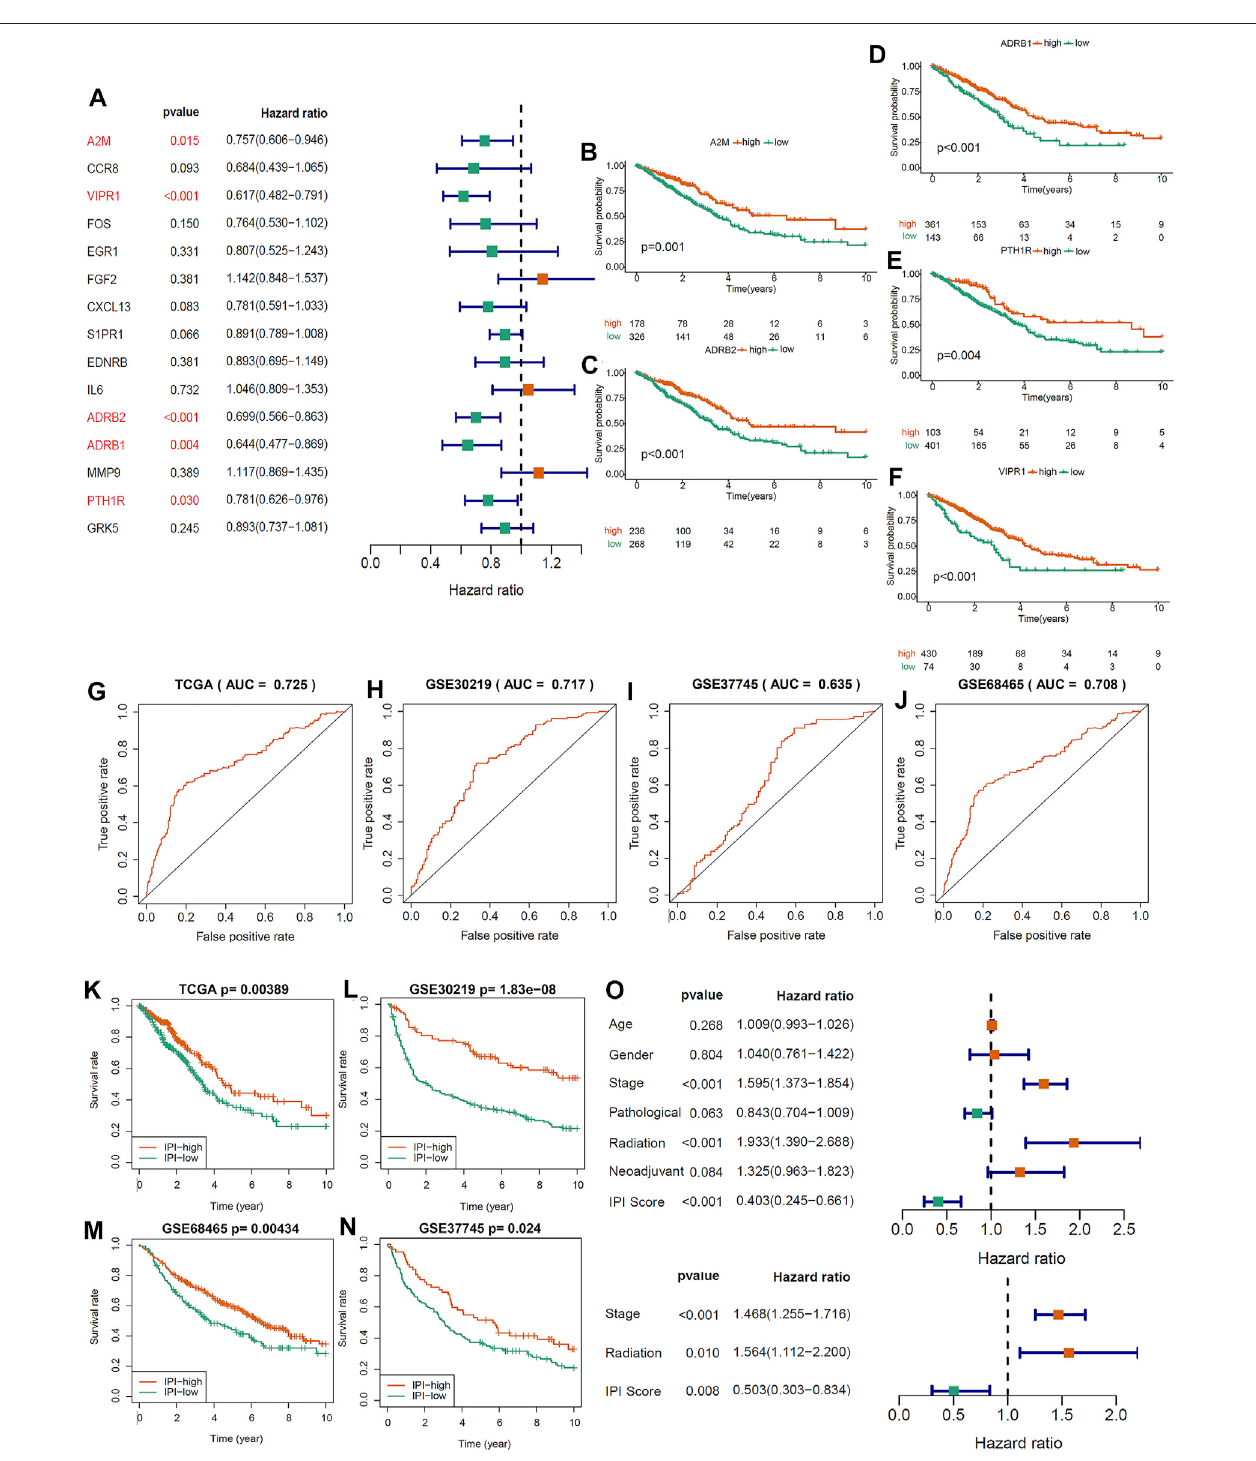
FIGURE2| Constructinganimmune-prognosisindex(IPI)forLUAD. (A) UnivariateCOXregressionanalysiswasusedtodeterminetheprognostic-relatedgenesin 15 immune hub genes. (B – F) Kaplan-Meier survival analysis of 5 prognostic-related genes ( p < 0.05). (G – J) ROC analysis of the IPI in the LUAD of TCGA and GEO cohorts. (K – N) Kaplan-Meier survival analysis of the IPI subgroups in the LUAD of TCGA and GEO cohorts ( p < 0.05). (O) Univariate and multivariate COX regression analysis to determine the independent prognostic value of IPI in LUAD.